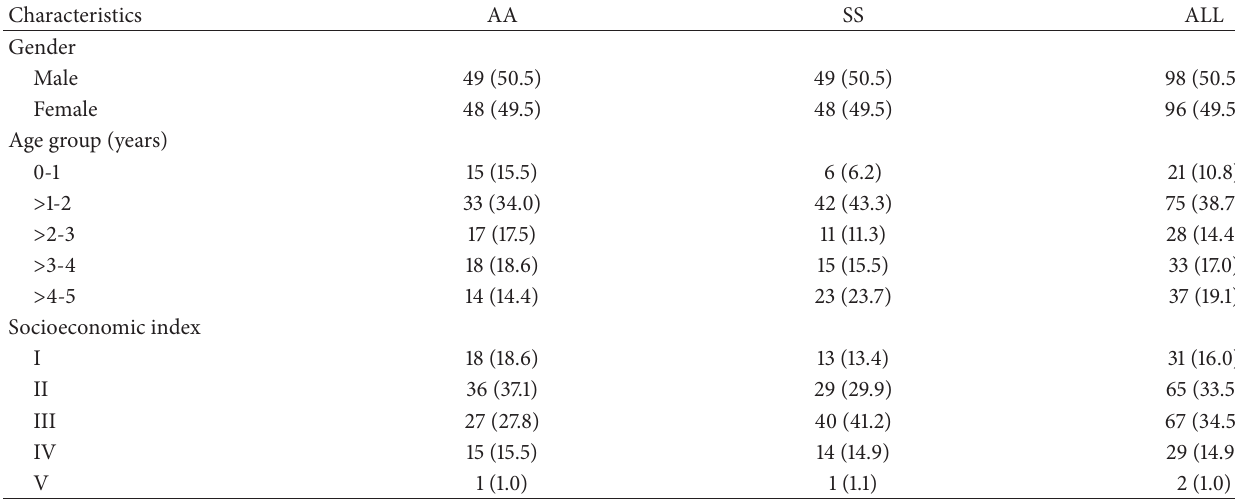
Table 1: Demographic characteristics of the study population.